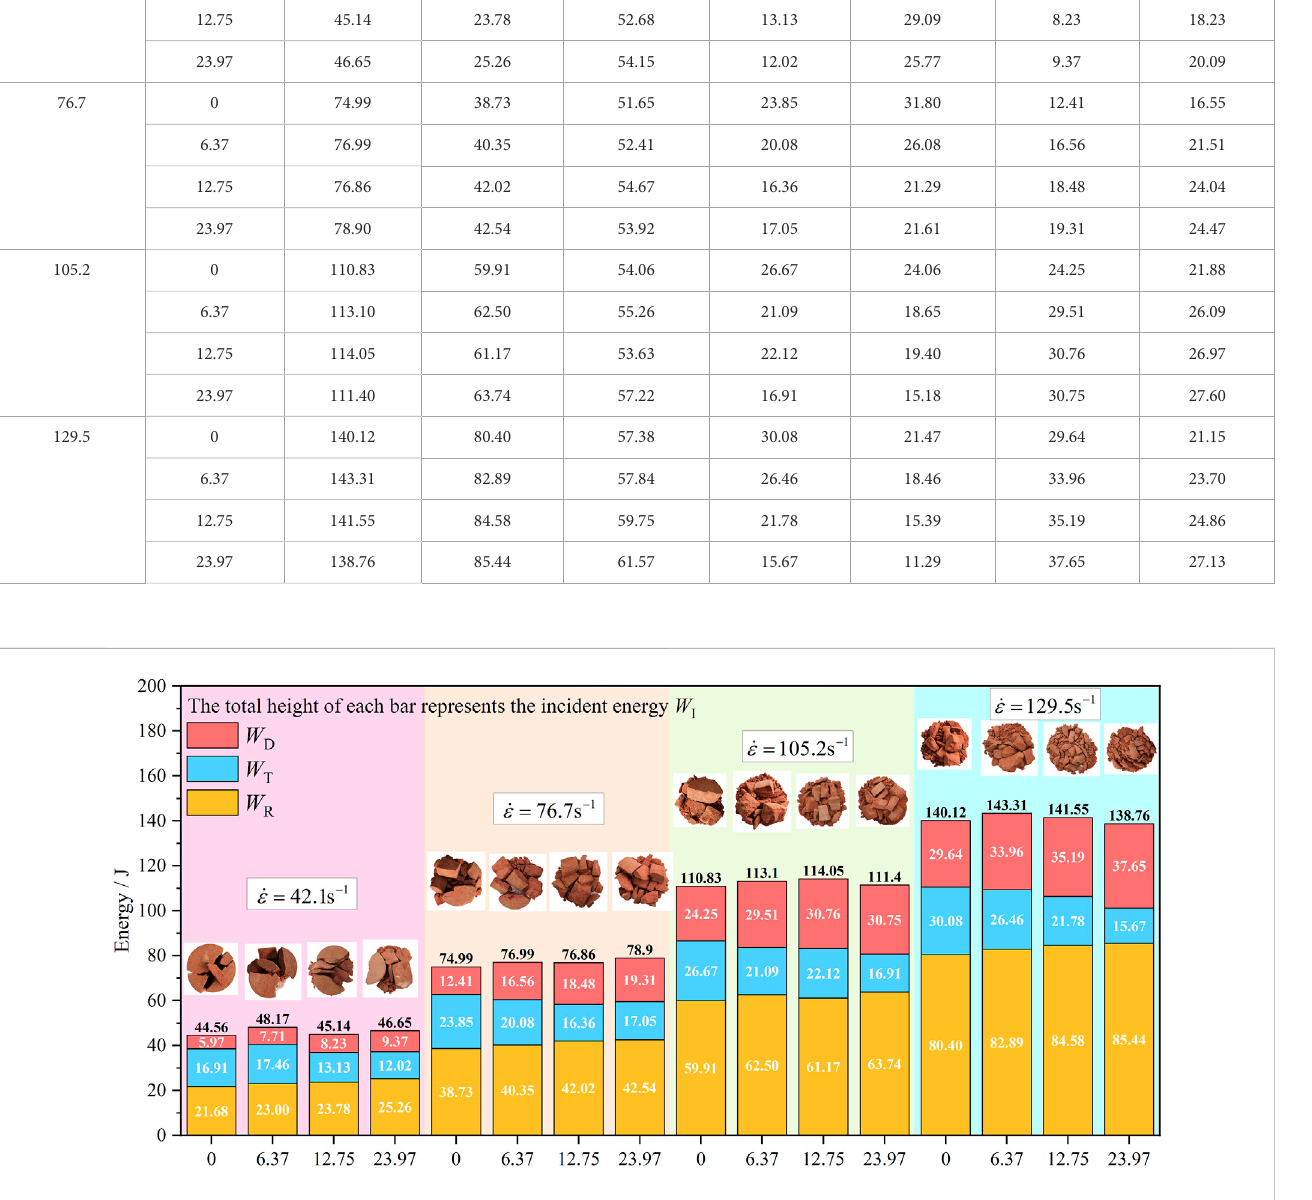
powder will appear with the increase of damage value in the dynamic failure process of sandstone. In addition, as the strain rate increases, the dissipated energy ratio gradually increases, and the energy utilization rate in the process of sandstone failure increases, which